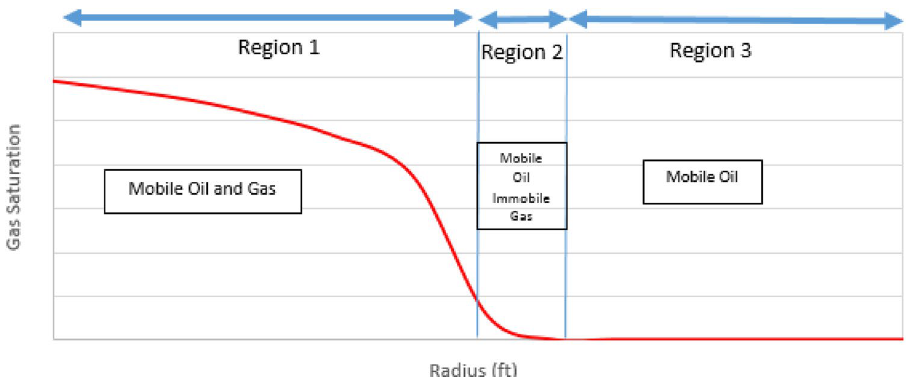
Fig. 1 Gas saturation in typical volatile oil